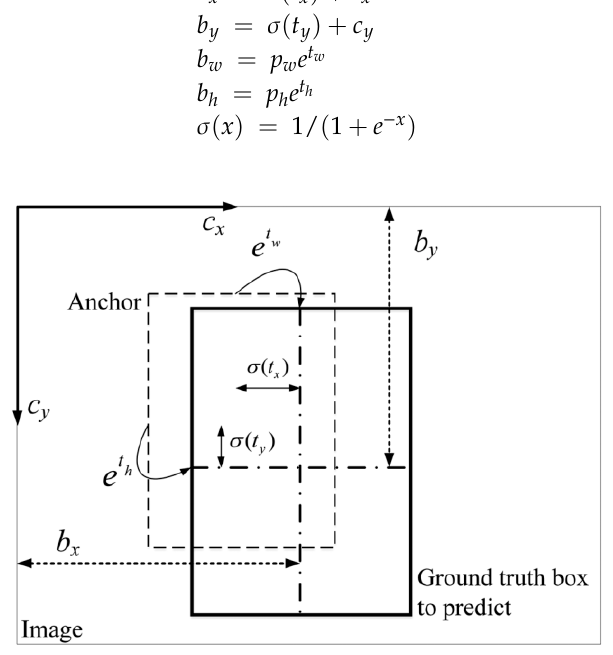
Figure 6. The final prediction.